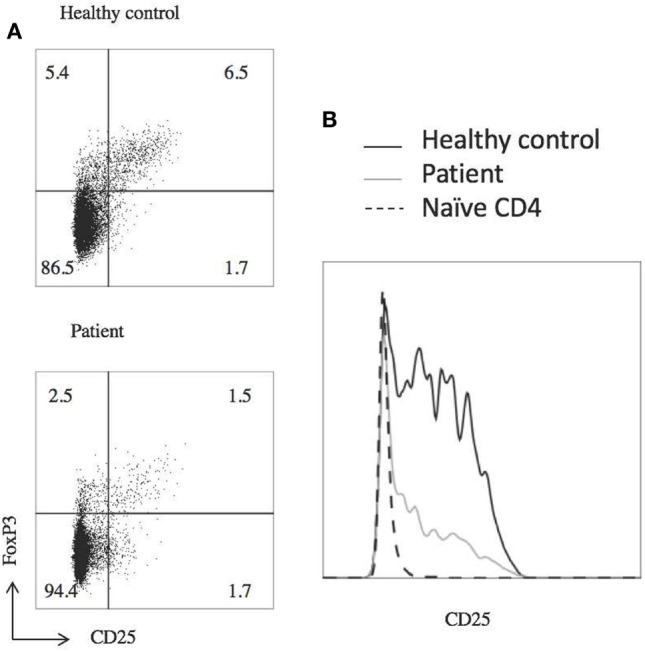
Patient has decreased T regulatory cell (T reg) numbers and expresses less CD25. (A) Flow cytometric analysis of T reg populations, gated on CD4+ T cells. (B) T regs have decreased CD25 expression, gated on CD4+ FOXP3+ CD127low cells. Dashed line shows naïve (CD45RO negative) T cells from a healthy control to show negative CD25 staining. Experiments were repeated at least twice with at least two healthy controls for each experiment.